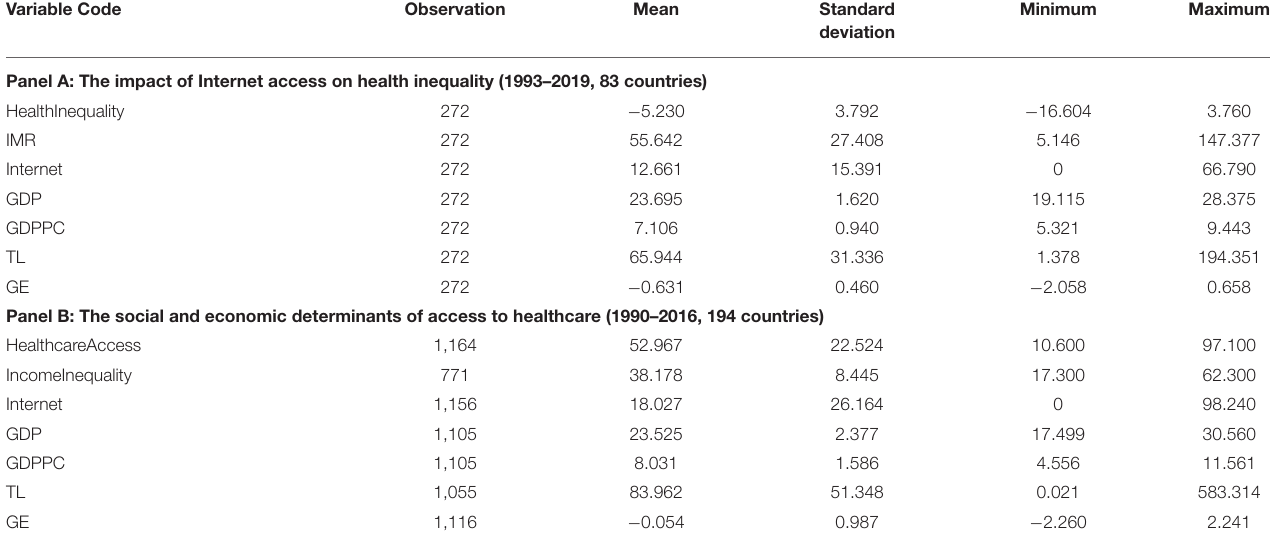
TABLE 2 | Descriptive statistics.